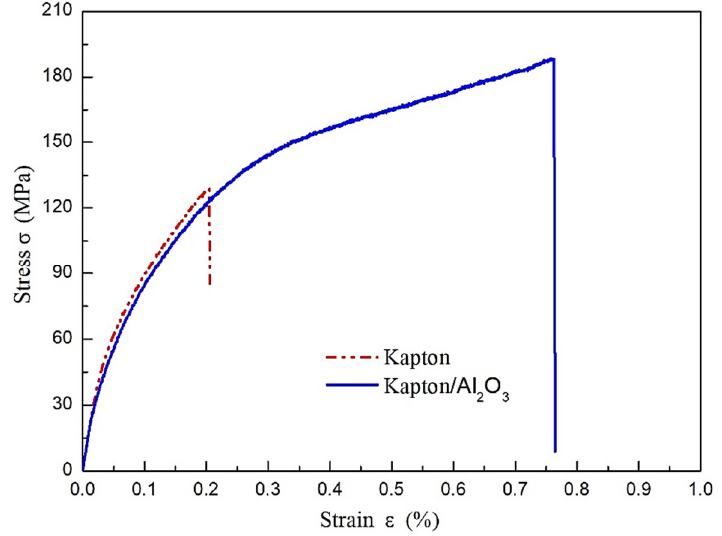
Figure 6. Stress–strain curve of Kapton film and Kapton/Al 2 O 3 composite film.